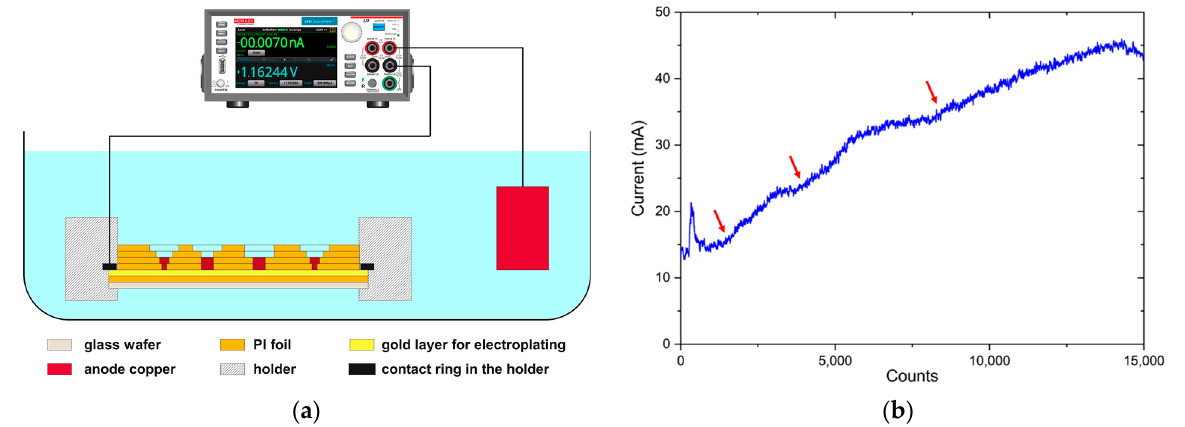
Figure 4. ( a ) Schematic illustration of the copper electroplating setup; ( b ) example of measured current over time at constant voltage of 600 mV. The counts in the diagram represent data points which were recorded with a frequency of approximately 12 measurements per second. The red arrows indicate the points where micro-via filling has just reached the next level of metallization.